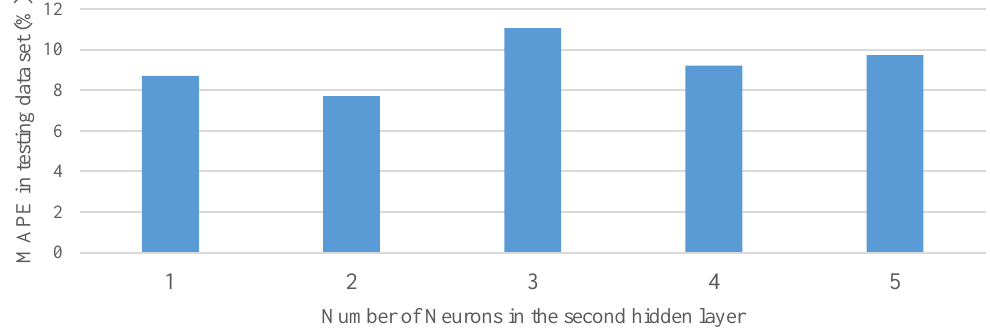
Figure 5. Comparison of MAPEs in testing set with different number of neurons in the second hidden layer.